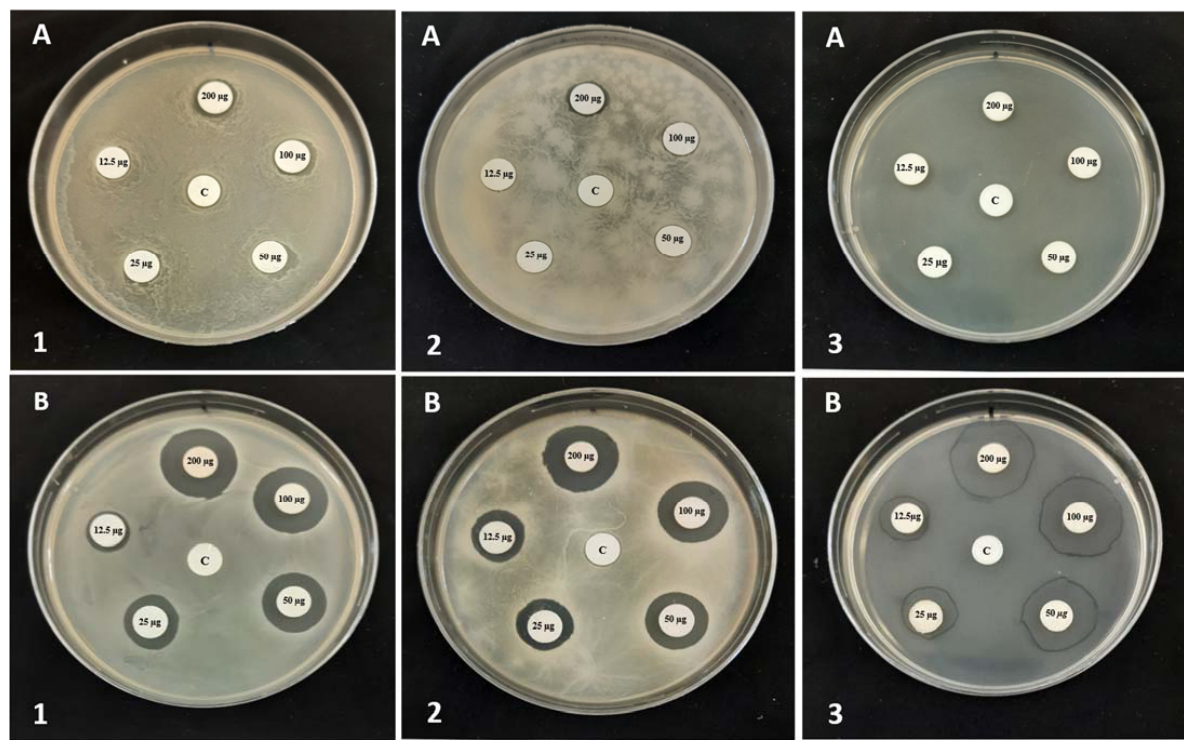
Figure 2. Effect of different concentrations of QHETA-9 (A) and QHETA-14 (B) on the growth of the Gram-positive bacteria S. aureus (1), MRSA (2) and E. faecalis (3).